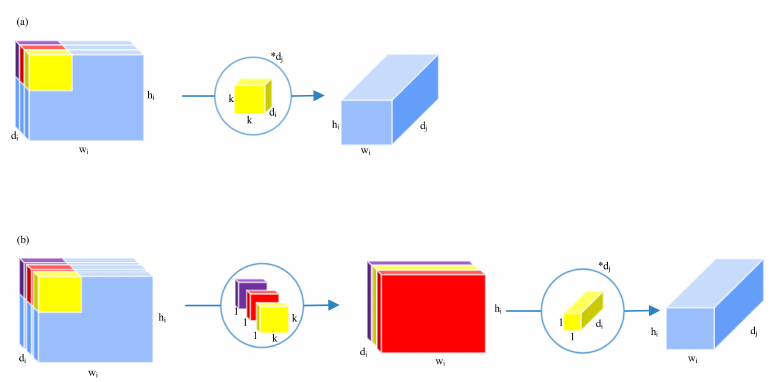
Figure 2. Two types of convolution images: ( a ) standard convolution; ( b ) depth-wise separable convolution.